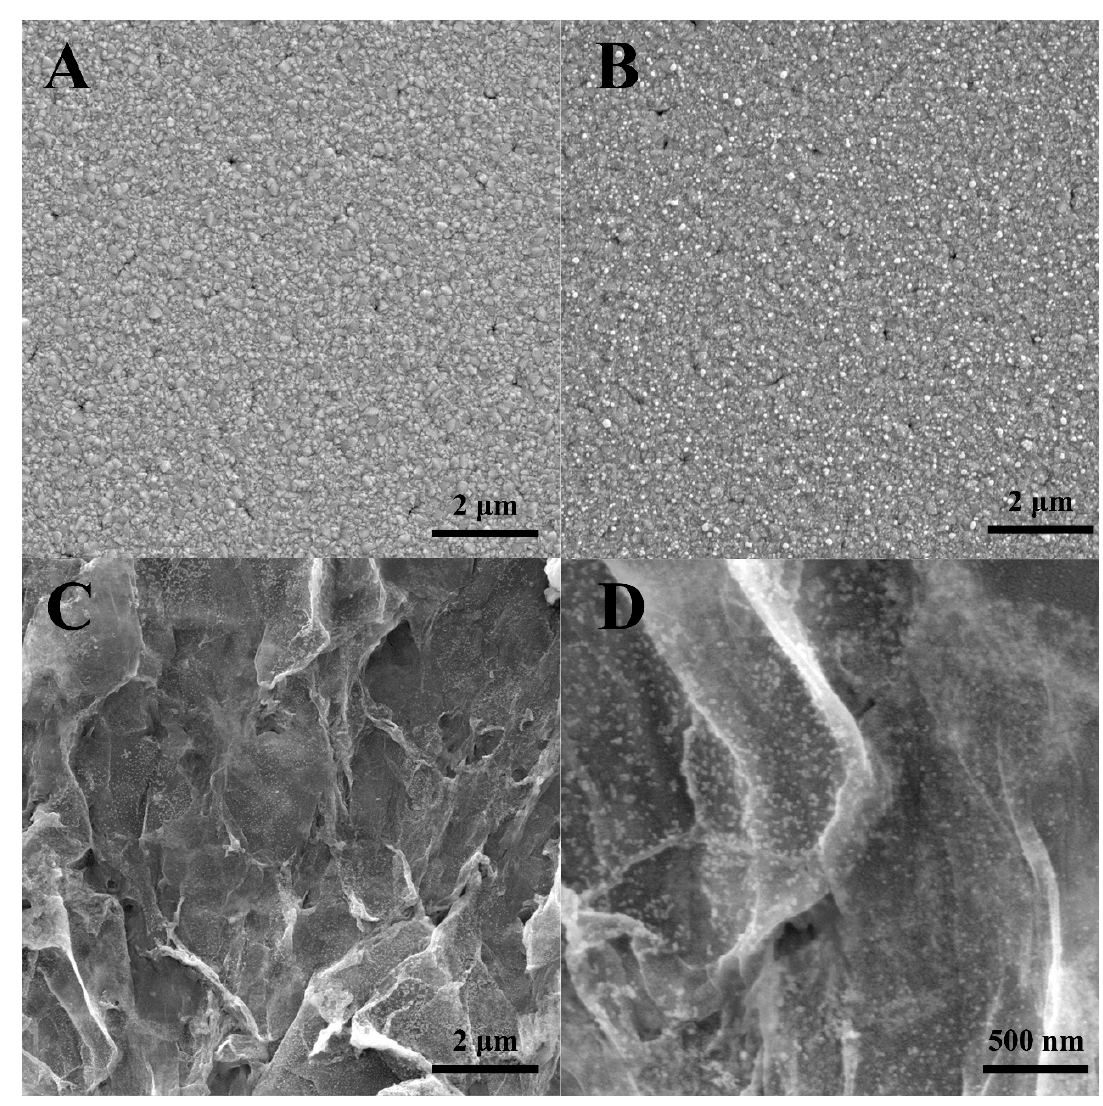
Figure 2. SEM images of FTO ( A ), Au/FTO ( B ), 3D Au-rGO/FTO ( C ) and higher magnification of 3D Au-rGO/FTO ( D ).